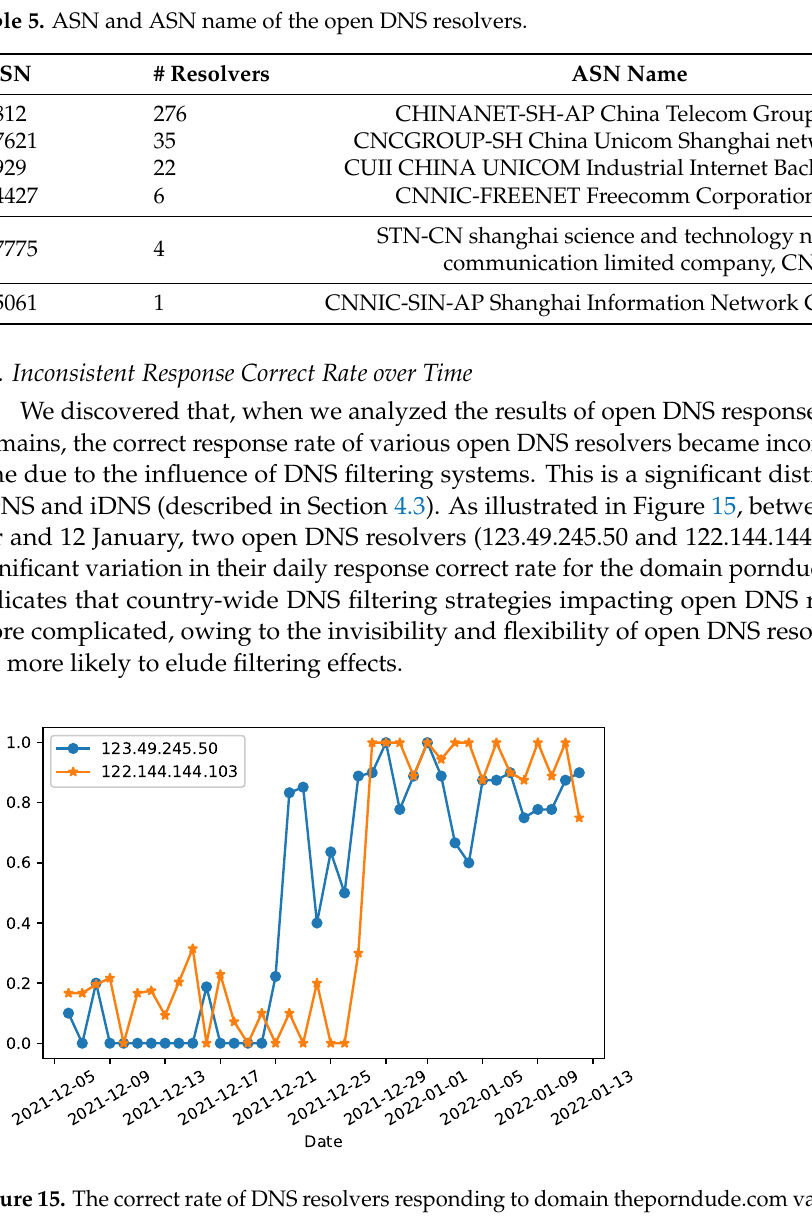
Figure 15. The correct rate of DNS resolvers responding to domain theporndude.com varies over